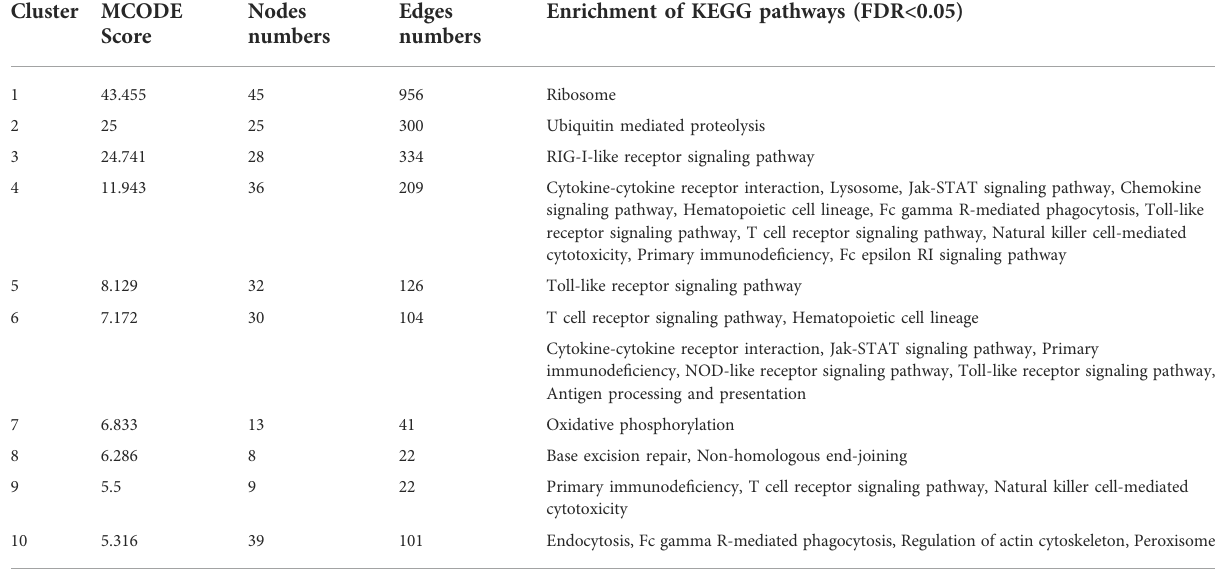
TABLE 5 MCODE identi fi ed 10 signi fi cant clusters from the PPI networks of DEGs, and GSEA identi fi ed enrichment of KEGG pathways ( p < 0.05) for a speci fi c gene set of the individual cluster. Cluster MCODE Nodes Edges Enrichment of KEGG pathways Score numbers numbers